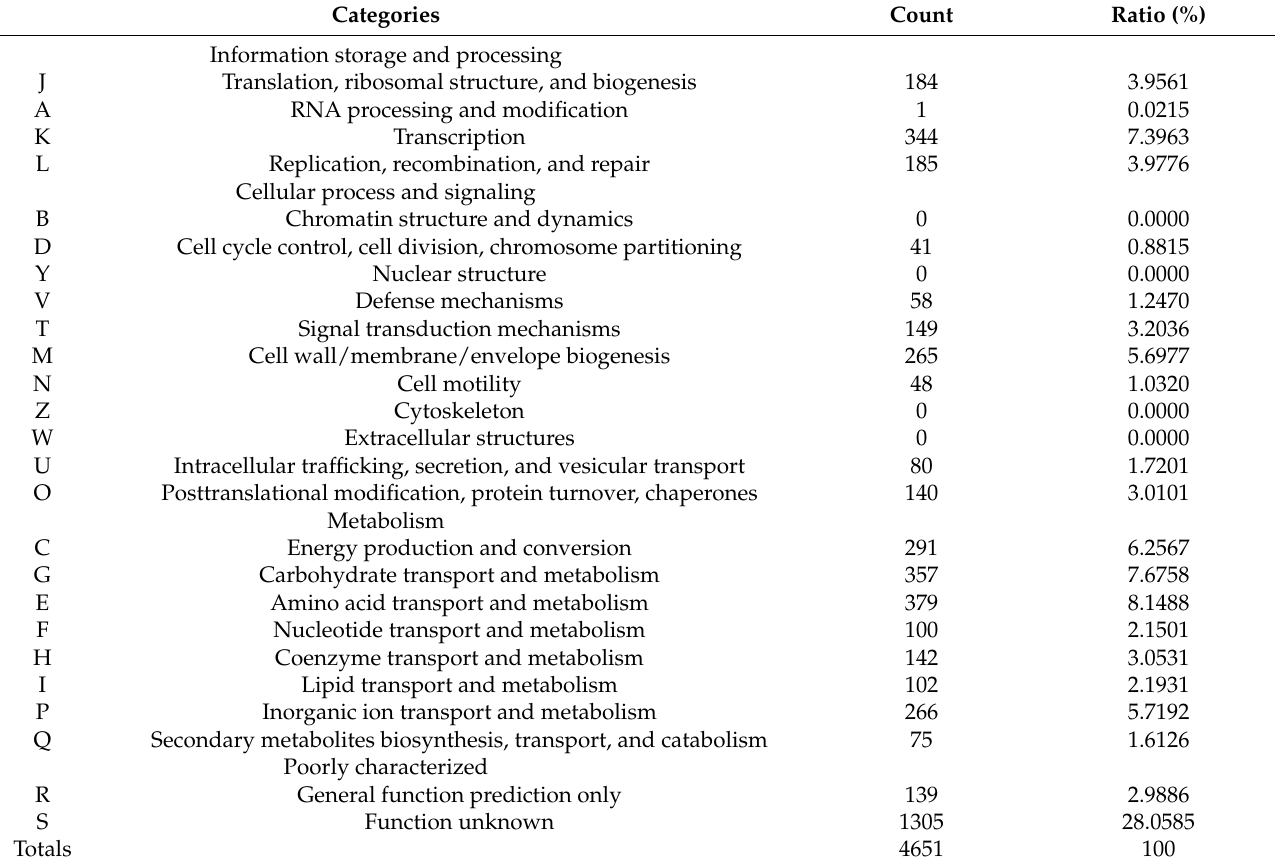
Table 1. COG functional categories of the genome sequence of J. calystegiae KSNA2 T